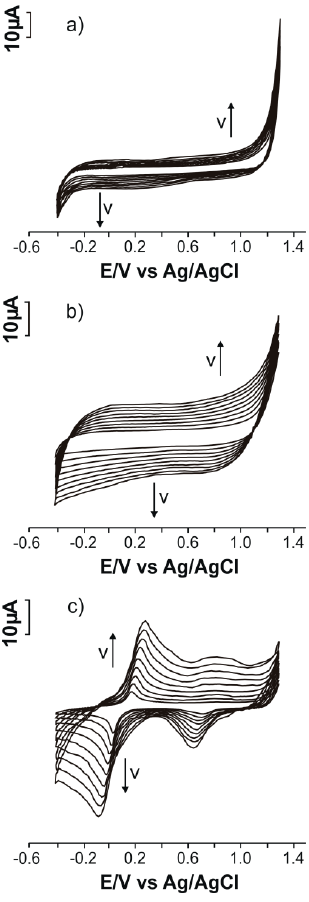
Figure 1. Cyclic voltammograms obtained with modified screen-printed carbon electrodes (SPCEs) in 10 − 1 M KCl solution with scan rates in the range 0.1–1.0 V × s − 1 : ( a ) CoPc-SPCE; ( b ) MB-SPCE; ( c ) PB- SPCE.